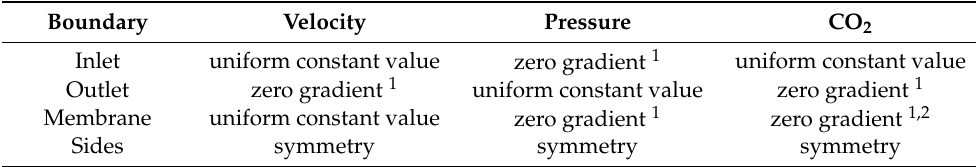
Table 3. Boundary conditions of the CO 2 transport simulations.